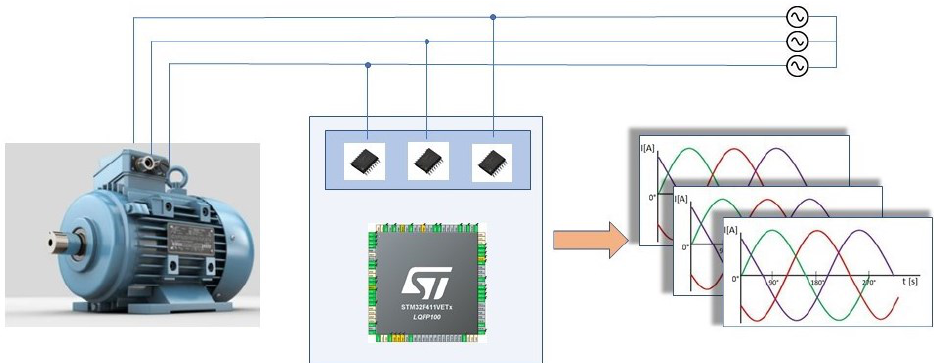
Figure 7. Data Acquisition Schema.